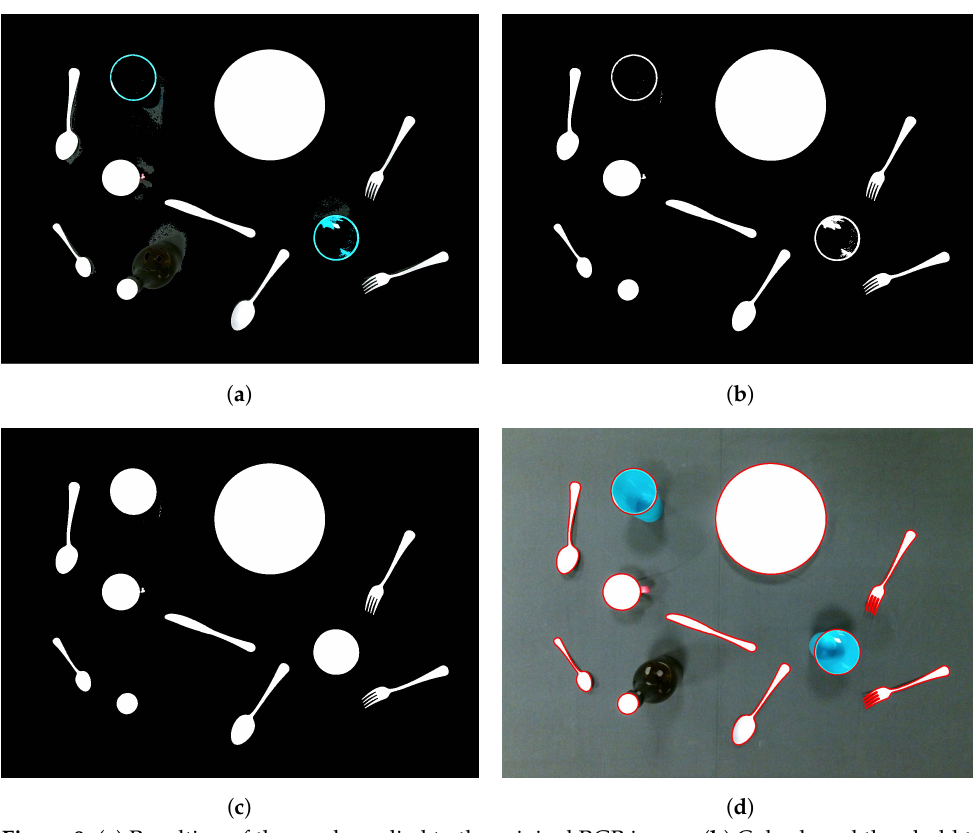
Figure 9. ( a ) Resulting of the mask applied to the original RGB image; ( b ) Color-based threshold to remove object shadows; ( c ) Flood-fill; ( d ) Boundary segmentation and blob